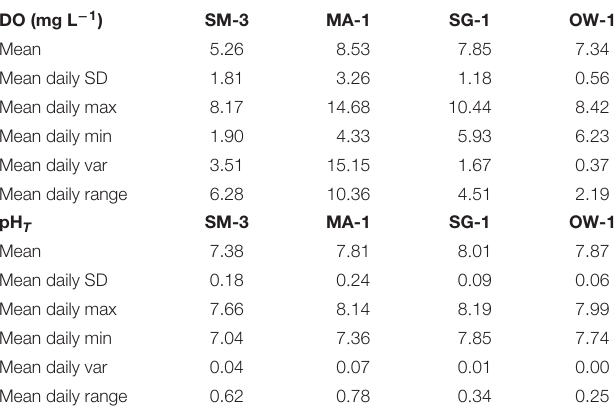
TABLE 1 | Daily mean ± SD, maximum, minimum, variance, and range in four distinct coastal